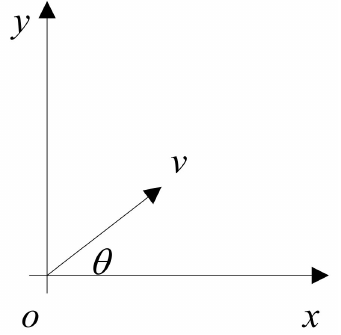
Figure 2. The decomposition of wind